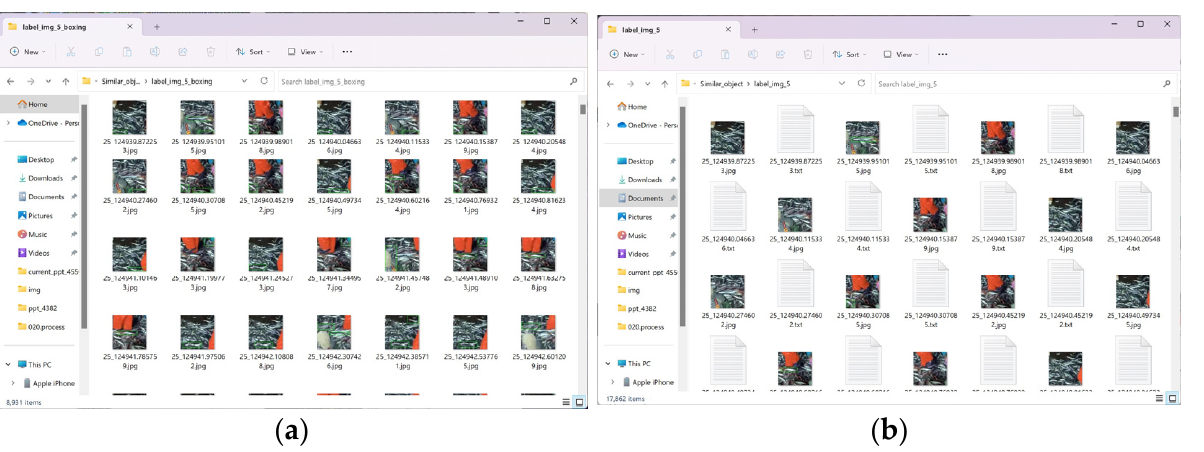
Figure 13. Example of automatic labeling using existing weights: ( a ) image with box recorded for review; ( b ) images and location information documents without box marks for learning.